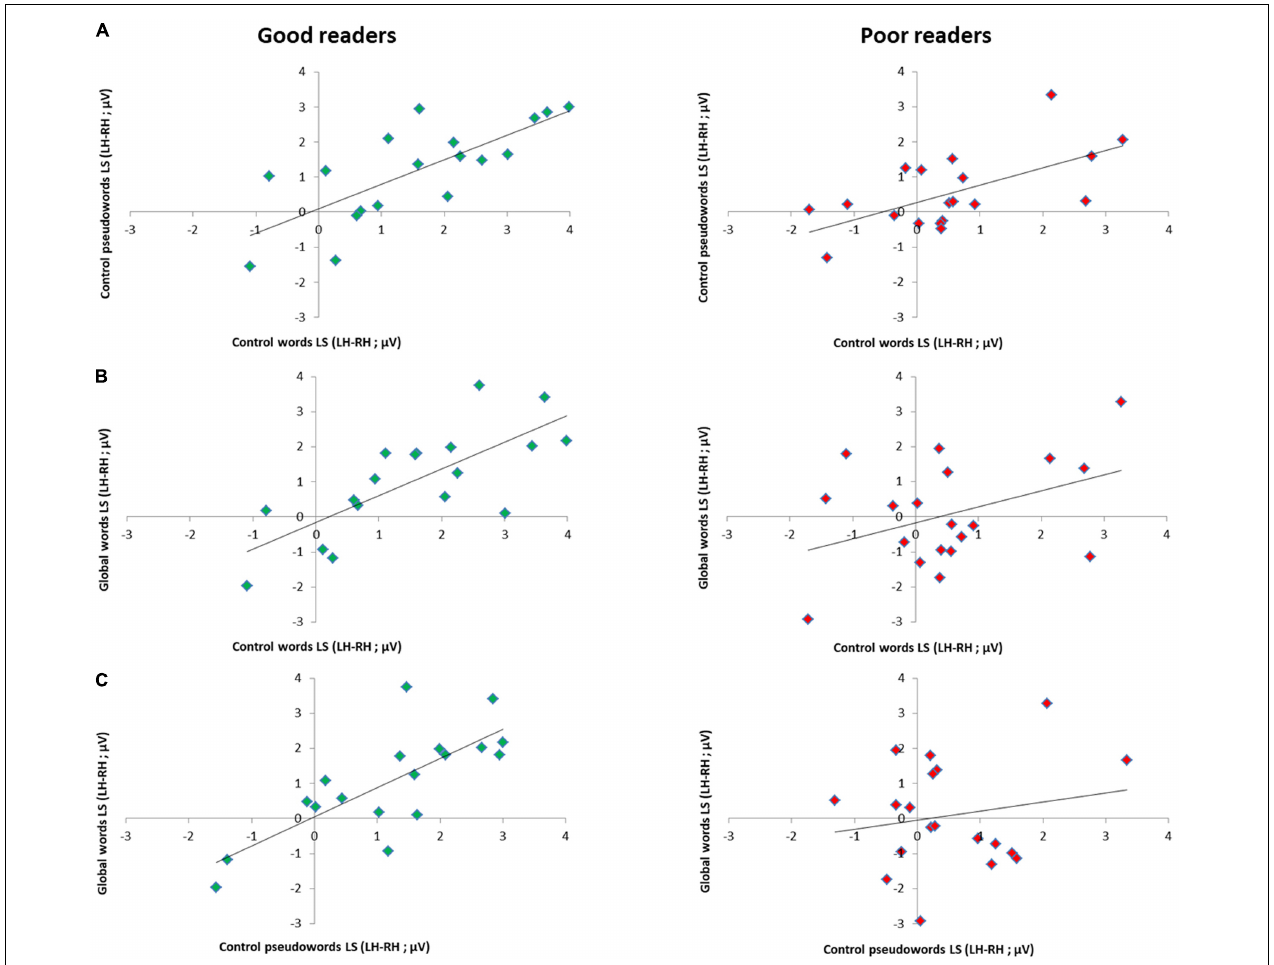
FIGURE 5 | Relation between EEG lateralization scores (LS) across conditions per reading level subgroup. Scatter plots of correlation analysis between EEG lateralization scores (LH-RH) for the responses to (A) control words and control pseudowords, (B) global words and control words and to (C) global words and control pseudowords in good readers ( N = 18, green dots) and poor readers ( N = 19, red dots). Correlations were all highly significant in good readers (all p < 0.001), while in poor readers, responses to global words did not correlate with control letter strings (with W: p = 0.22; with PW: p = 0.44), which correlated together ( p = 0.002), suggesting atypical processing of global